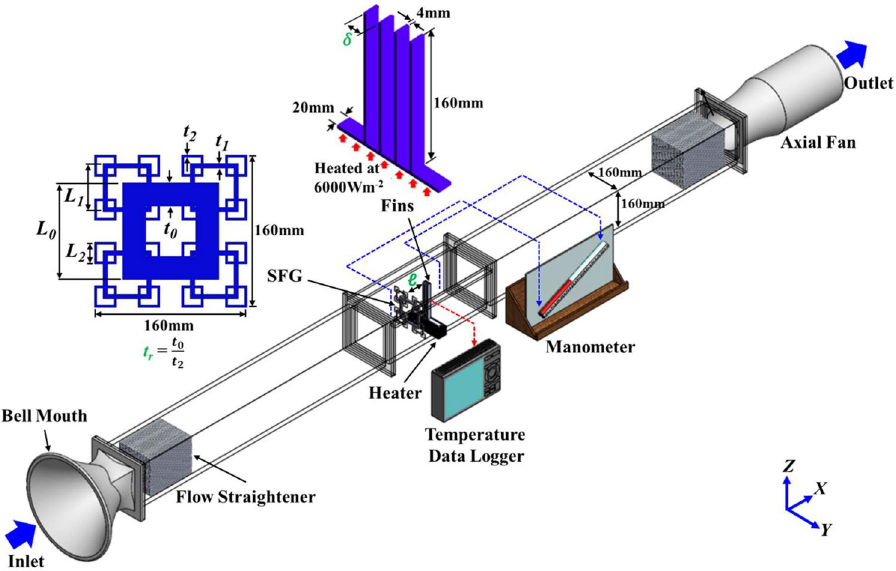
Figure 5. Experimental setup for plate-fin heat sink heat transfer under insert generated turbulent